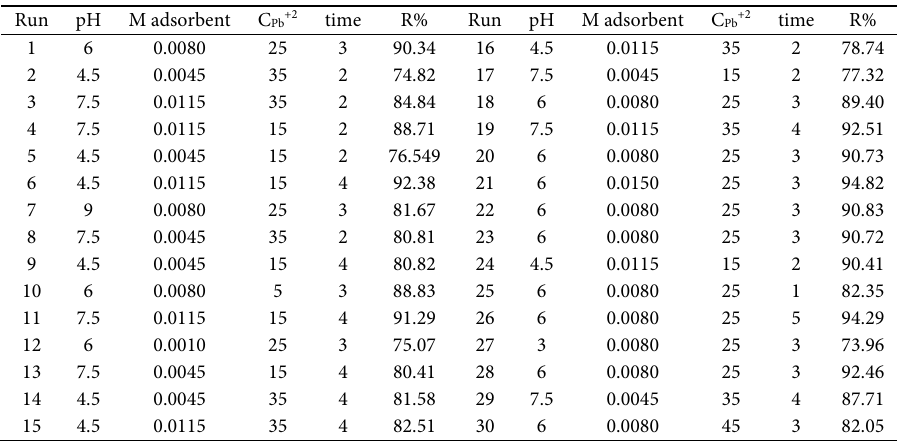
Table 3. Design matrix for the